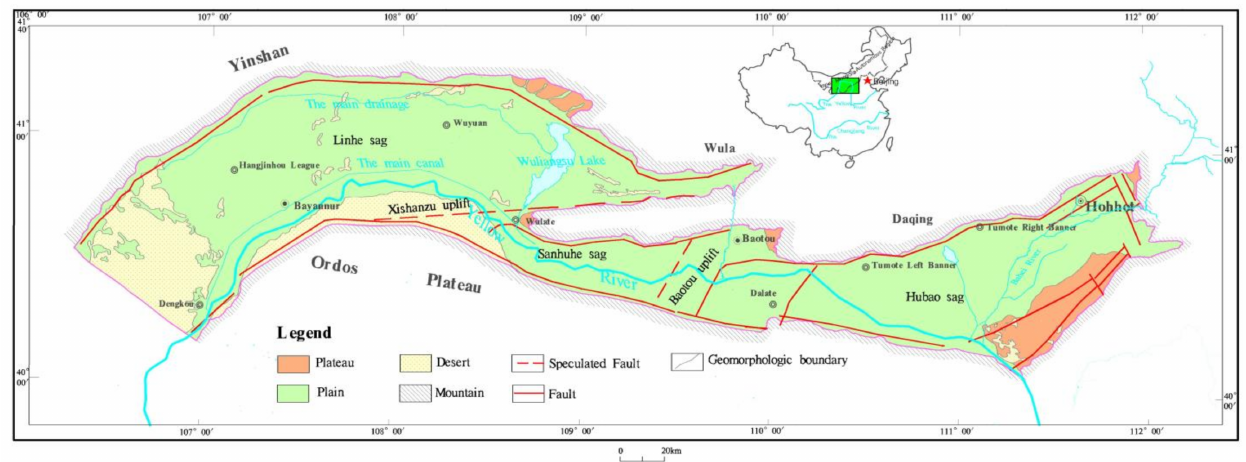
Figure 1. Geologic and geomorphologic map of the Hetao